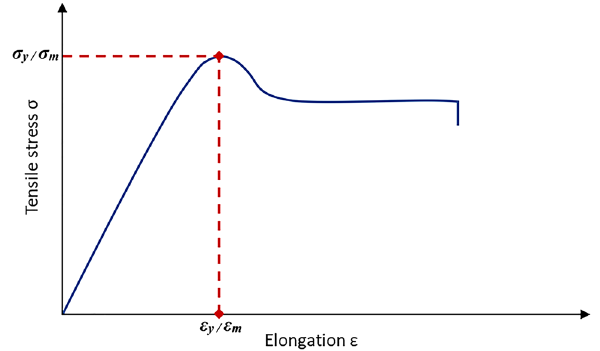
Fig. 2 Generalized curve of the stress–strain diagram for the mate- rial PETG. Based on DIN EN ISO 527-1:2019-12